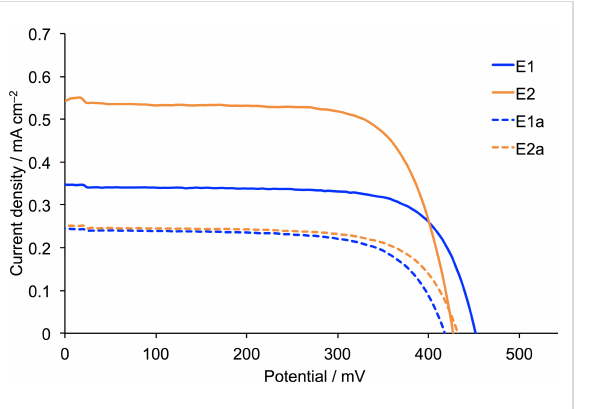
Figure 2: J–V curves for DSCs containing dye 1 electrolytes E1–E4 with different ionic liquids. The solvent is MPN.